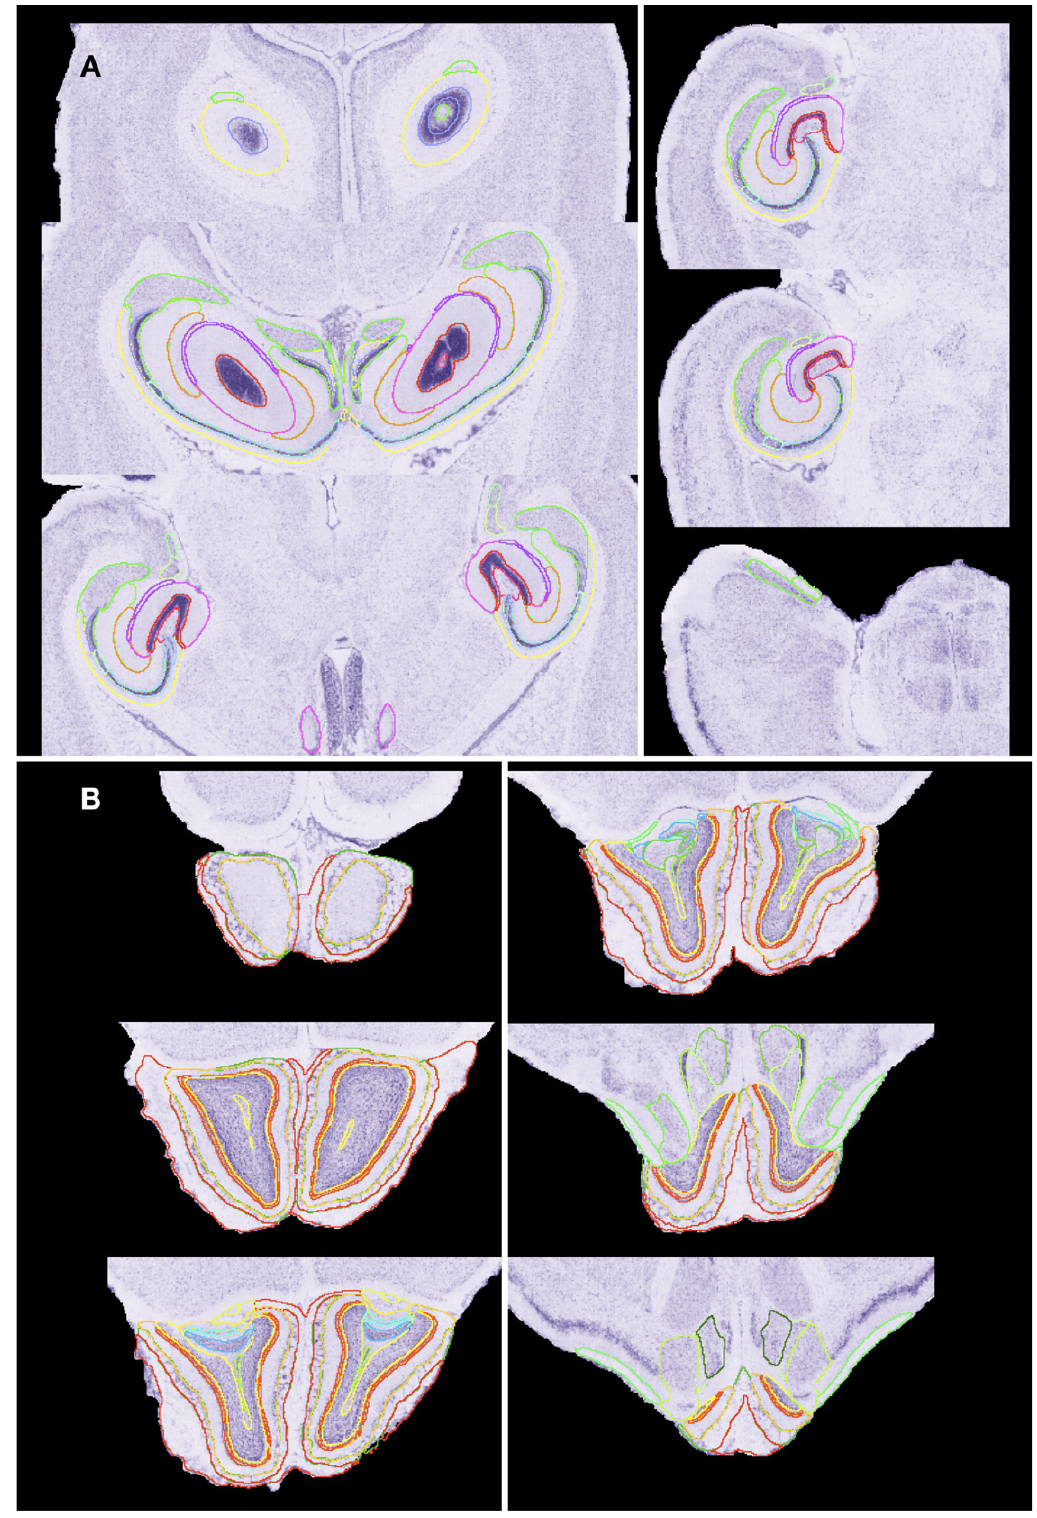
Figure 3 | Fine structure delineations. Shown are selected horizontal atlas levels with full delineation of the hippocampus (A) and olfactory bulb (B) . Outline colors in (A) : CA1 to CA3 represented in different values of blue; dentate gyrus (DG) – pink; fasciola cinereum-gold; granule layer of DG-red; hippocampal fi ssure-purple; molecular layer of DG-orange; oriens layer of the hippocampus-yellow; parasubiculum-green; polymorph layer of DG-pink-purple; presubiculum- light green; pyramidal cell layer of the hippocampus-dark baby blue; striatum radiatum of the hippocampus-light forest green; subiculum-green. Outline colors in (B) : Accessory olfactory bulb (OB) and anterior olfactory nucleus-light green value; Dorsal lateral olfactory tract-turquoise; ependyma and subependymal layer of ventricle of OB-light lime green; external plexiform layer of OB and accessory olfactory bulb (AOB)-yellow-gold; glomerular layer of OB-dark green and of AOB-yellow-green; granule layer of AOB-blue; granule cell layer of OB-yellow; internal plexiform layer of OB-orange; lateral olfactory tract-green; mitral cell layer of OB-red; mitral cell layer of the AOB-light turquoise; olfactory nerve